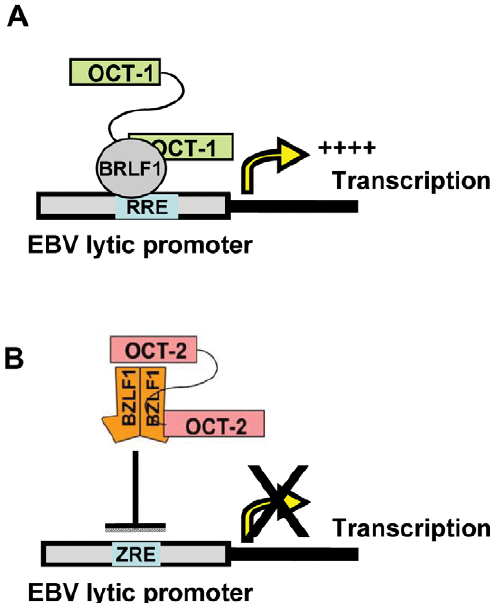
Figure 11. Hypothesized model for Oct-1 and Oct-2 regulation of EBV lytic reactivation. (A) Oct-1 enhances lytic reactivation through a direct protein-protein interaction between Oct-1 and the IE protein BRLF1, which promotes BRLF1 DNA-binding and tethers Oct-1 to viral DNA. (RRE; BRLF1 responsive element) (B) Oct-2 promotes latency by interacting with the BZLF1 IE protein and inhibiting its DNA- binding. (ZRE; BZLF1 responsive element).